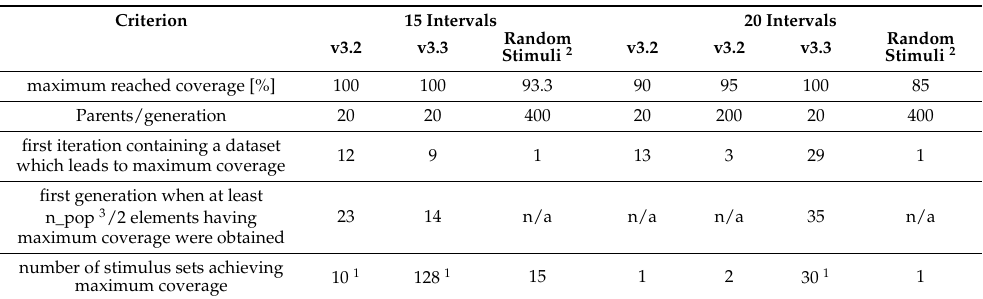
Table 7. Results obtained when the Ambiental controller was stimulated with values provided by programs based on genetic